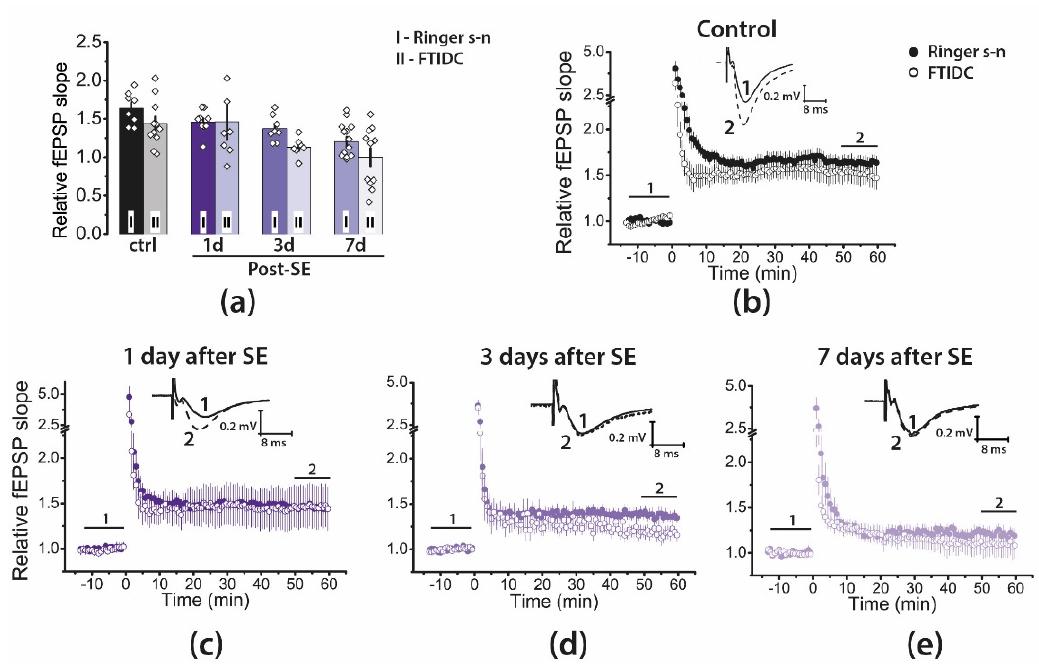
Figure 5. Pharmacological properties of LTP in the CA1 hippocampus of juvenile rats during the latent phase of the lithium–pilocarpine model of temporal lobe epilepsy. ( a ) Diagram illustrating the magnitude of plasticity in the control and experimental groups in the presence of FTIDC. Between 7 and 10 animals were in each group. One or two brain slices were used from one animal. The diamonds show the individual values for each brain slice. Two-way ANOVA following Tukey’s post hoc tests was used. No significant effects of FTIDC were detected. ( b – e ) The normalized fEPSP slope in the control ( b ) and experimental groups ( c – e ) in the presence of a selective mGluR1 antagonist, FTIDC (5 μ M), before and after HFS. Representative examples of fEPSP in the presence of FTIDC were recorded before induction (1) and 50–60 min after HFS (2).